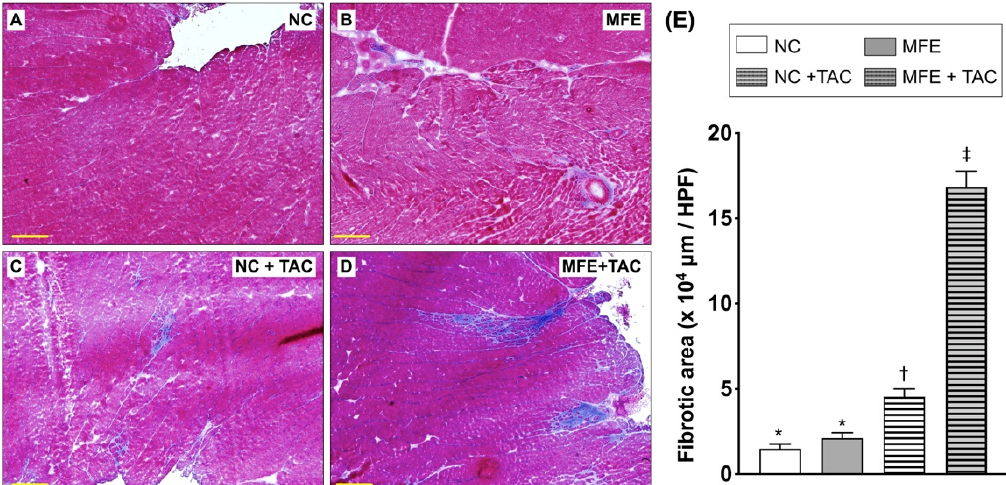
Figure 2. Masson’s trichrome (MTC) staining on myocardial sections of offspring with maternal fructose exposure (MFE) and ventricular pressure overload induced by transverse aortic constriction (TAC). ( A ) Normal control rat offspring. ( B ) Rat offspring with MFE. ( C ) Normal control rat offspring with TAC. ( D ) Rat offspring with MFE and TAC. ( E ) Comparison of myocardial fibrotic areas among treatment different groups. NC, normal control. Groups with different symbols (*, †, ‡), p < 0.05. n = 8 for each group. Scale bar in left lower corner indicates 200 µm.